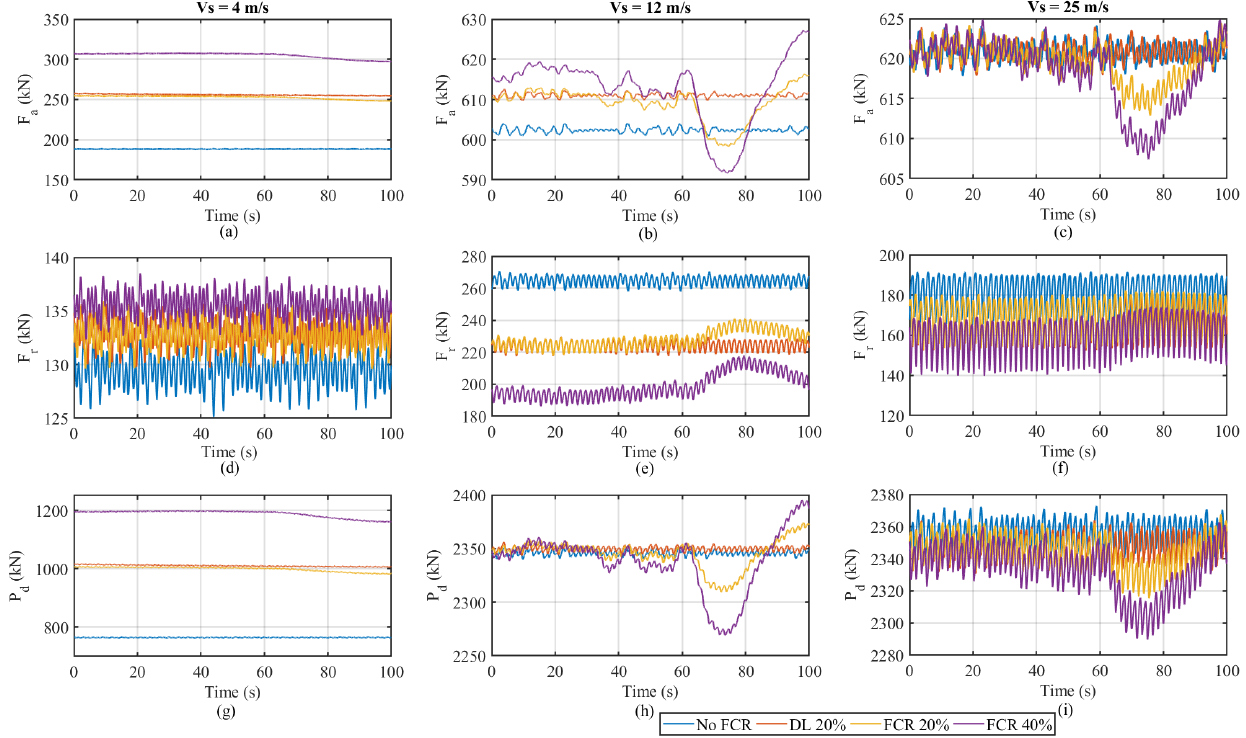
Figure 11. Dynamic forces acting on the wind turbine’s main